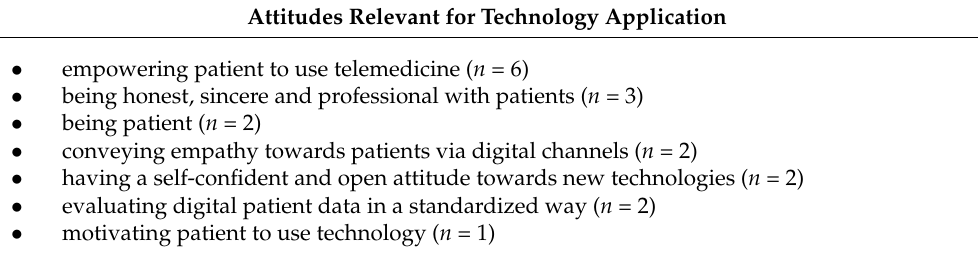
Table 4. Most relevant attitudes for telenursing as chosen by the Parkinson nurses. Attitudes Relevant for Technology